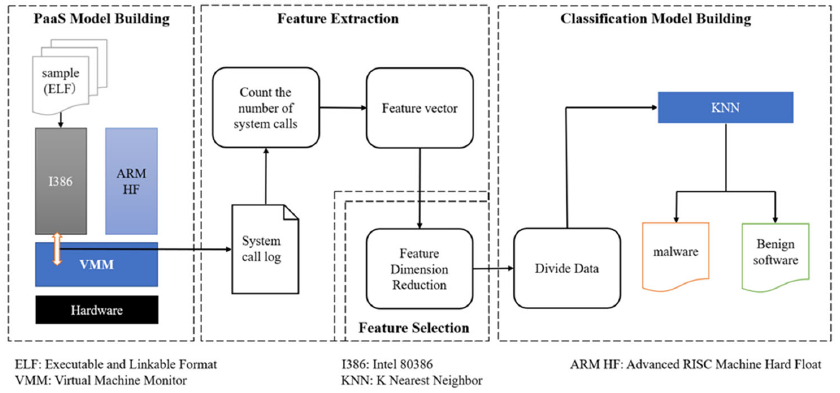
Figure 1. System